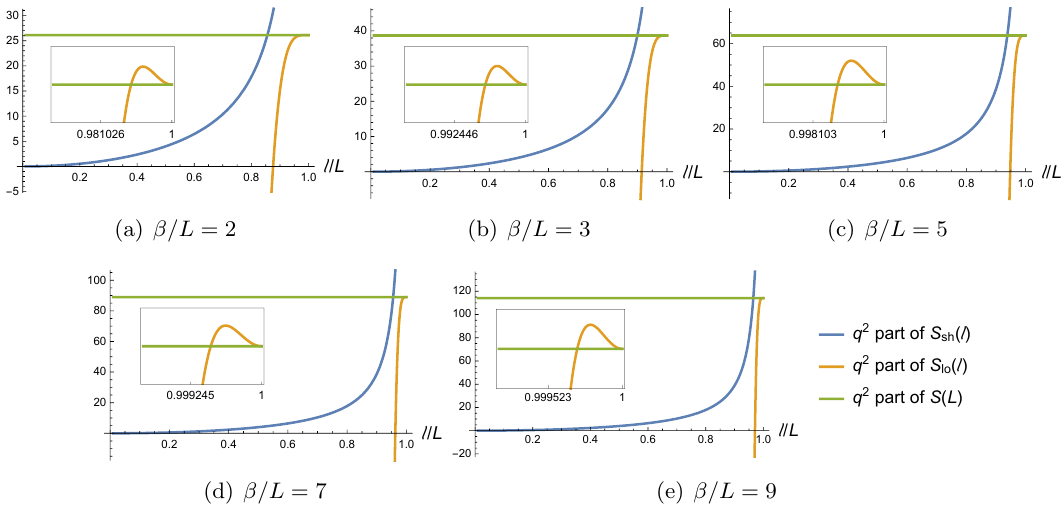
Figure 8 . The q 2 parts of thermal entropy and the entanglement entropies of the short interval and the long interval. There is no overlapping for the validity regions of the short interval and long interval